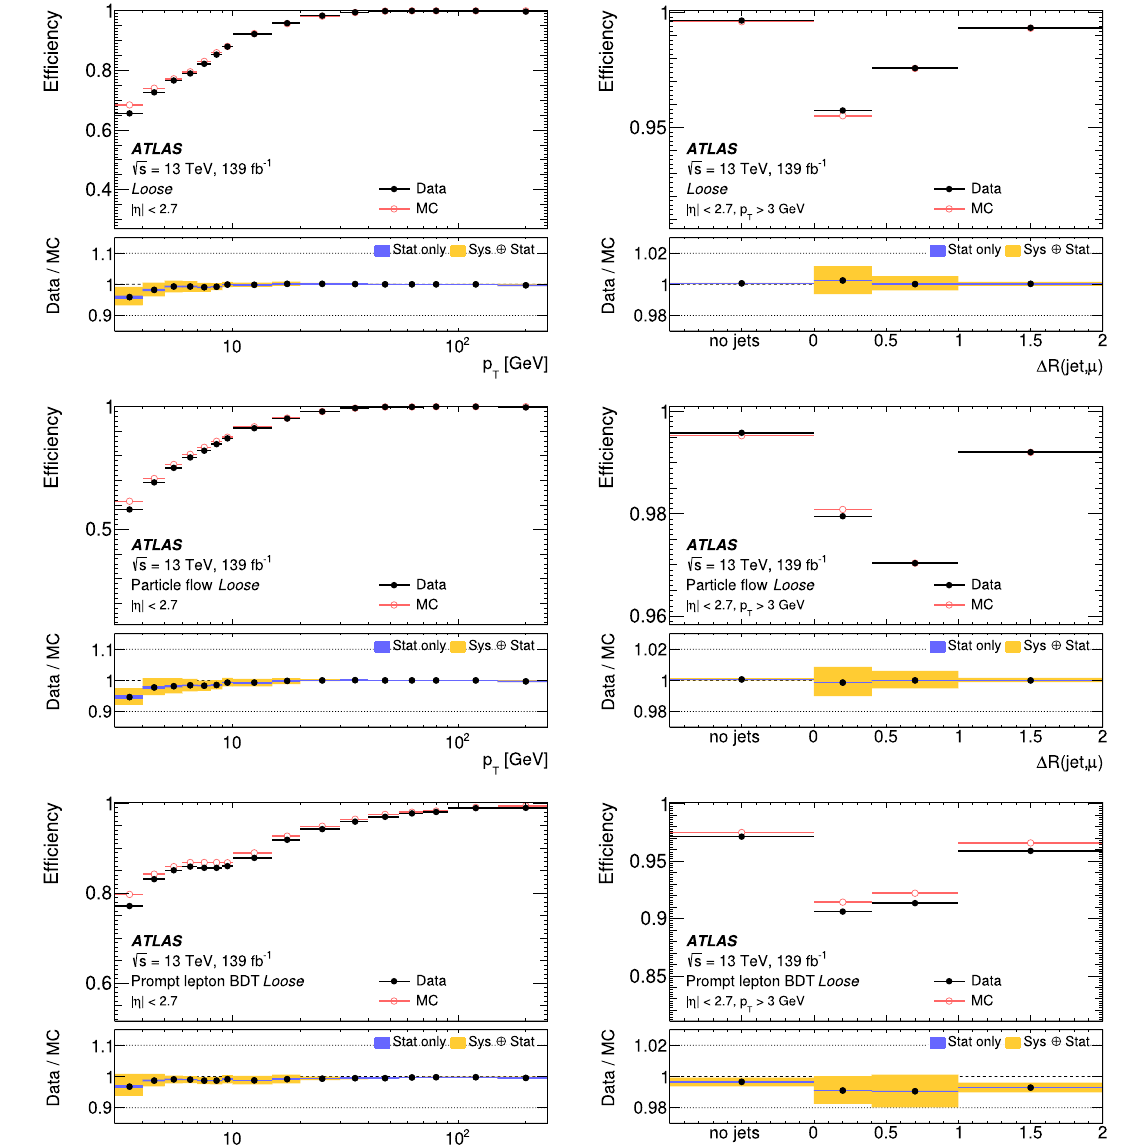
Fig. 19 Muonisolationefficiencymeasuredin Z → μμ eventsforthe Loose (top plots), PflowLoose (middle plots), and PLBDTLoose (bot- tom plots) criteria, as a function of p T (left plots) and (cid:8) R ( jet ,μ) (right plots) for muons with p T > 3 GeV. The statistical uncertainty in the